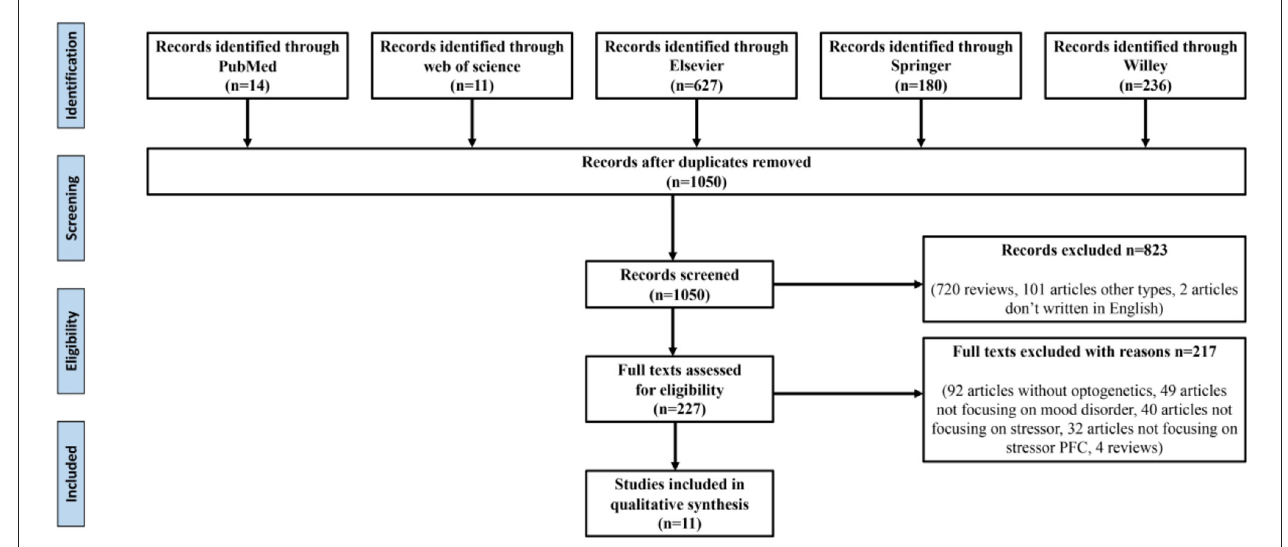
FIGURE 1 | Data retrieval